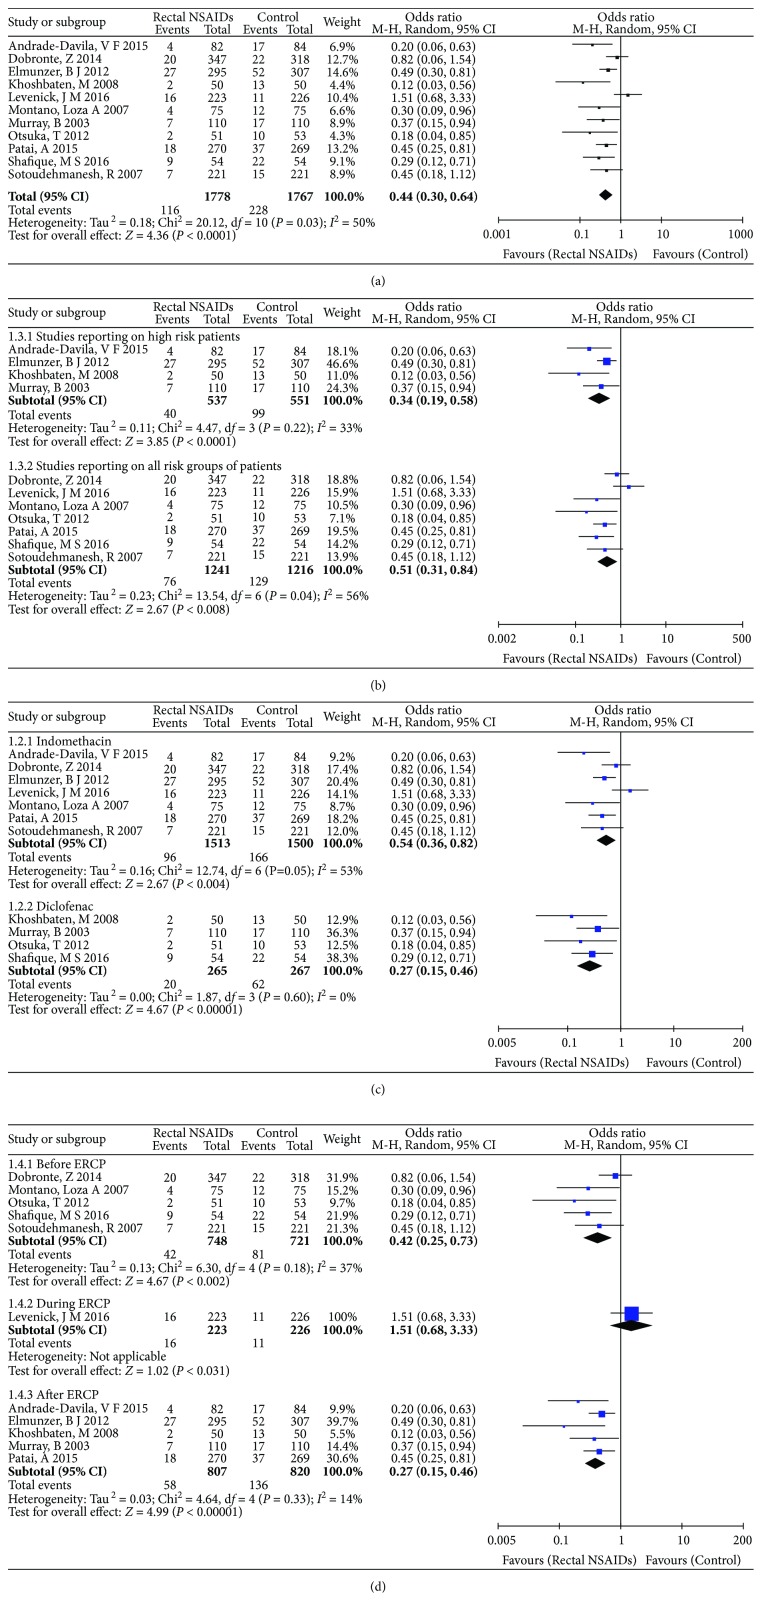
Primary outcome: (a) forest plot showing the effect of rectal administration of NSAIDs on the incidence of PEP; (b) subgroup analysis according to different risk patients; (c) subgroup analysis according to different drugs; (d) subgroup analysis according to the timing of drug administration.